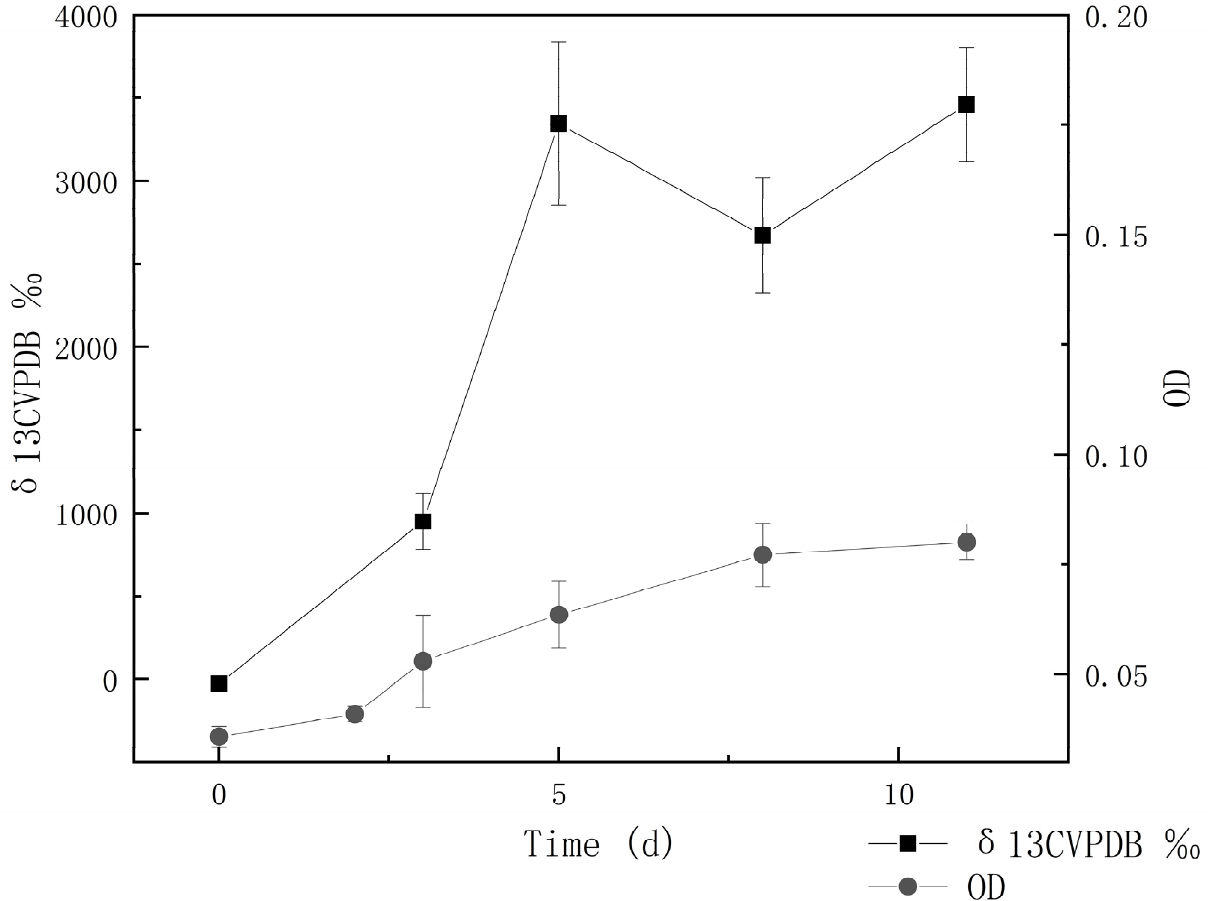
Figure 5. Growth curve and carbon-fixation capacity of Pseudomonas sp. IOP_13 grown in an autotrophic thiosulfate–containing medium.